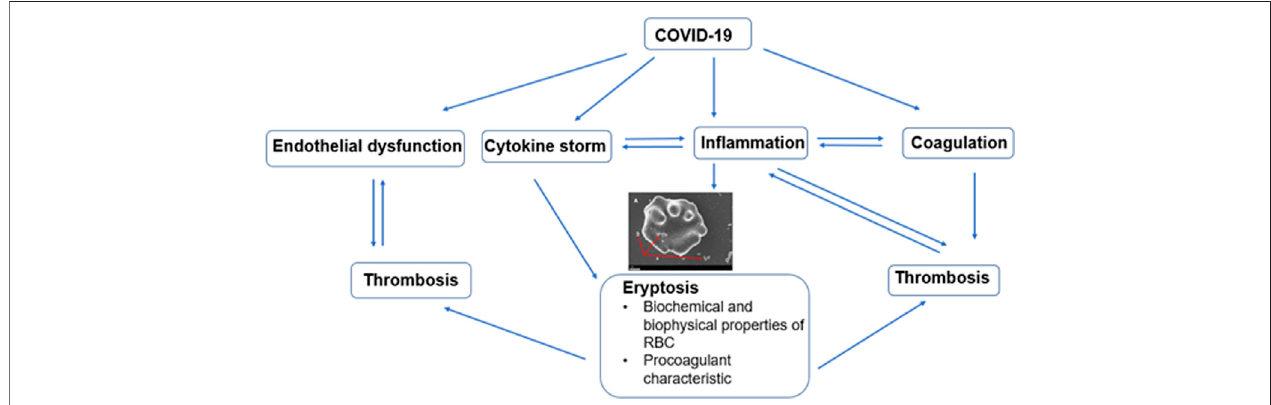
FIGURE2| Diagramshowinginterplay betweeneryptosisandcomplicationssuchasendothelialdysfunction,cytokinestorm,in fl ammation,andcoagulation.Allof which contribute to the increased thrombotic burden observed in COVID-19 disease.